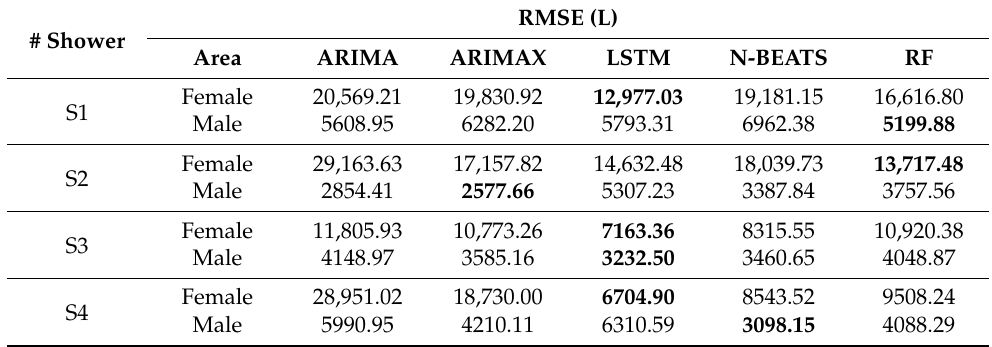
Figure 6. Illustration of the observed and forecasted values for hourly BWD of each shower room using ARIMA, ARIMAX, LSTM, RF, and N-BEATS models, ( a , c , e , g ) for female areas, ( b , d , f , h ) for male areas. Table 5. RMSE of models (bold indicates the best result for the corresponding shower room and